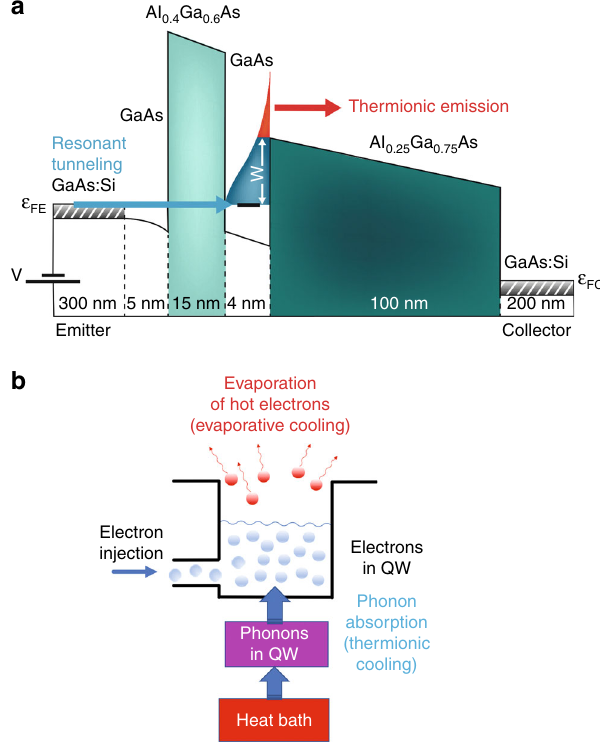
Fig. 1 The asymmetric double-barrier heterostructure for evaporative electron cooling. a Band diagram of the asymmetric double-barrier heterostructure. Electron transport mechanism, i. e., the resonant tunneling through the thinner barrier (blue arrow) and the thermionic emission above the thicker barrier (red arrow), is schematically shown. b Schematic diagram for the heat fl ow in the electron-lattice system in the heterostructure. The concepts of the evaporative and thermionic cooling are schematically